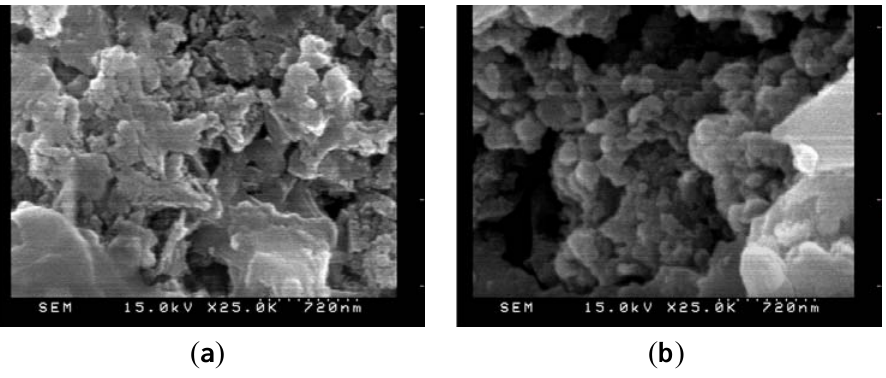
Figure 13. SEM micrograph of the cement-based material with fly ash admixture (×25 k): ( a ) Before leaching; ( b ) After leaching.